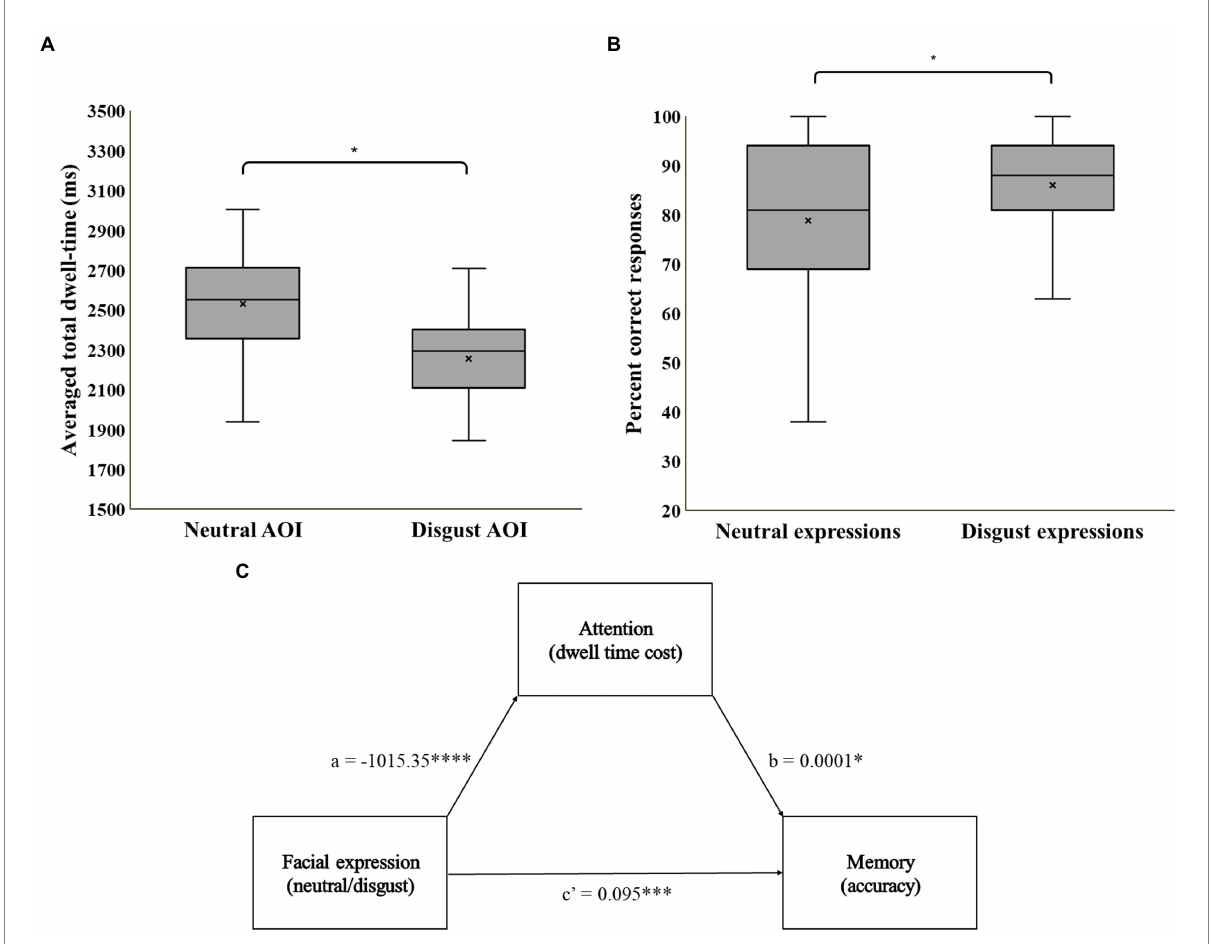
Figure 2C. Results indicate a direct effect of facial expression on memory, b = 0.095, SE = 0.02, p < 0.001, 95% CI (0.73, 0.80), an effect of facial expression on attention, b = − 1015.35, SE = 250.007, p < 0.001, 95% CI ( − 1515.11, − 515.59), and an effect of